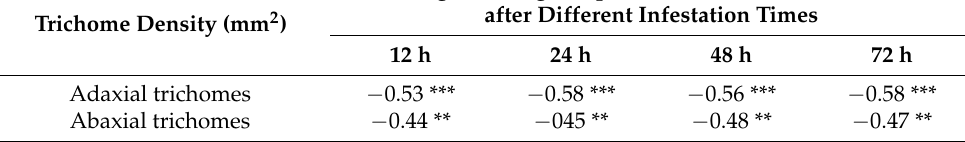
Table 5. Linear correlations between leaf trichome density and percentage of winged S. miscanthi settled on wheat accessions and varieties 12, 24, 48 and 72 h after being released. Percentage of Winged Aphids Settled on Wheat Accessions after Different Infestation Times Trichome Density (mm 2 ) 12 h 24 h 48 h 72 h Adaxial trichomes − 0.53 *** − 0.58 *** − 0.56 *** − 0.58 *** Abaxial trichomes − 0.44 ** − 045 ** − 0.48 ** − 0.47